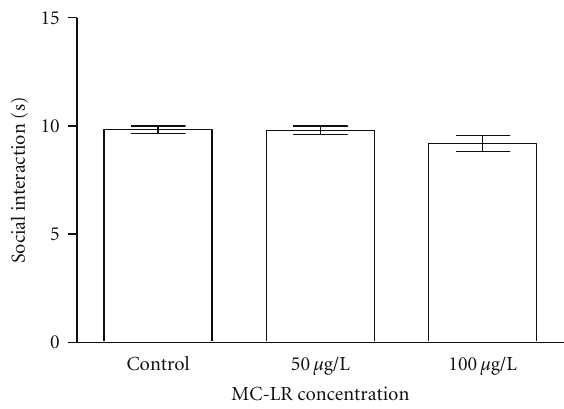
Figure 2: E ff ect of exposure to microcystin-LR on social interac- tion. Data expressed as mean ± SEM. n = 10. One-way ANOVA/ Newman-Keuls post hoc test.